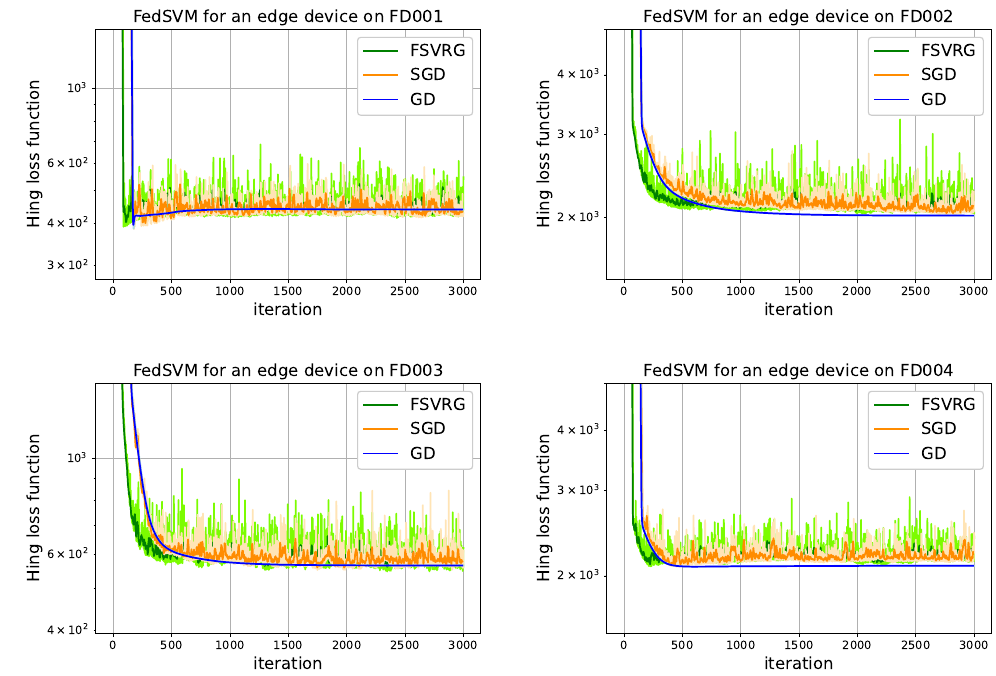
Figure 9. Convergence time of syncronous FedSVM based on the communication of Figure 6 with different